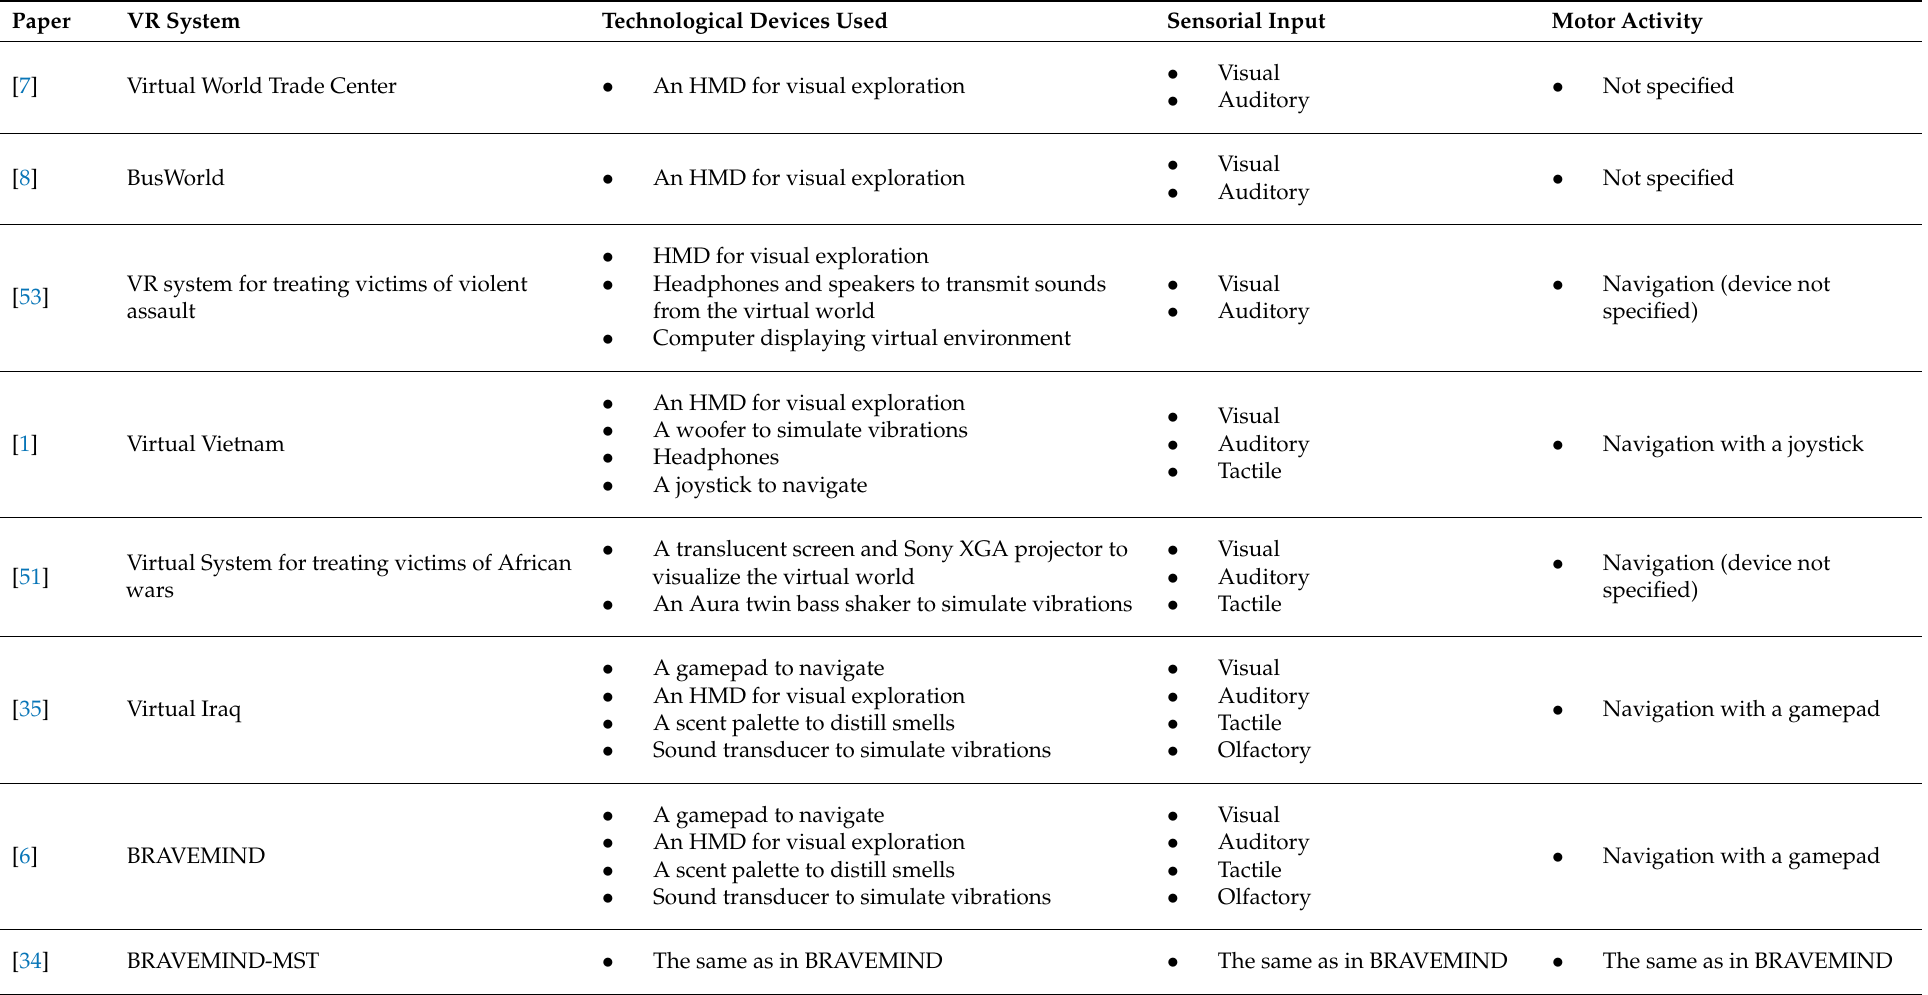
Table 1. Summary of the review of virtual reality tools exploited in the treatment of post-traumatic stress